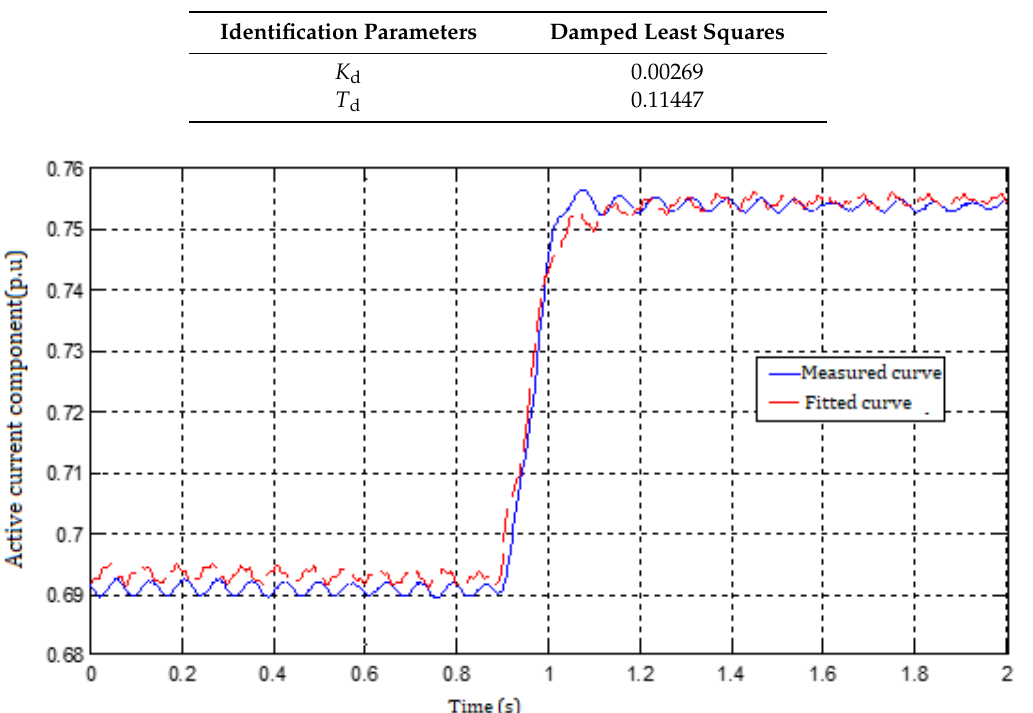
Figure 11. Grid voltage curve with small disturbance of grid voltage. Table 1. Parameter identification results under small disturbance of grid voltage.